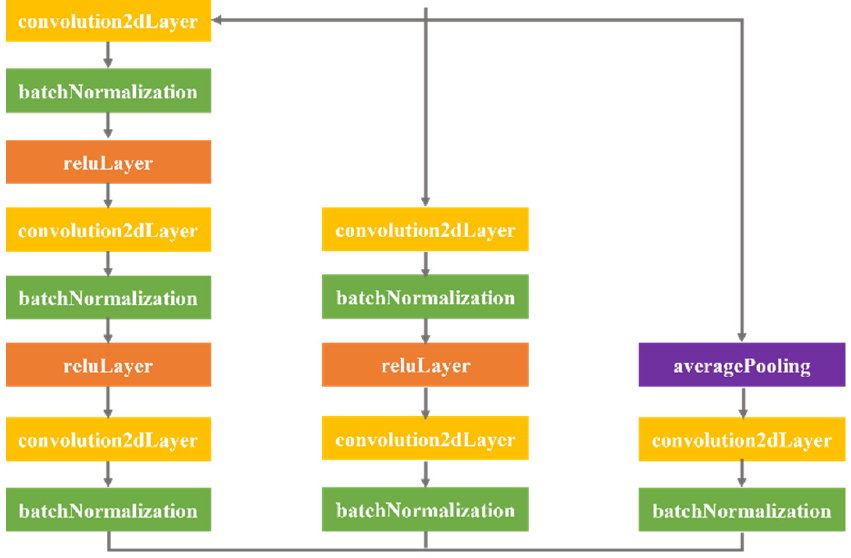
Figure 2. Improved residuals module.